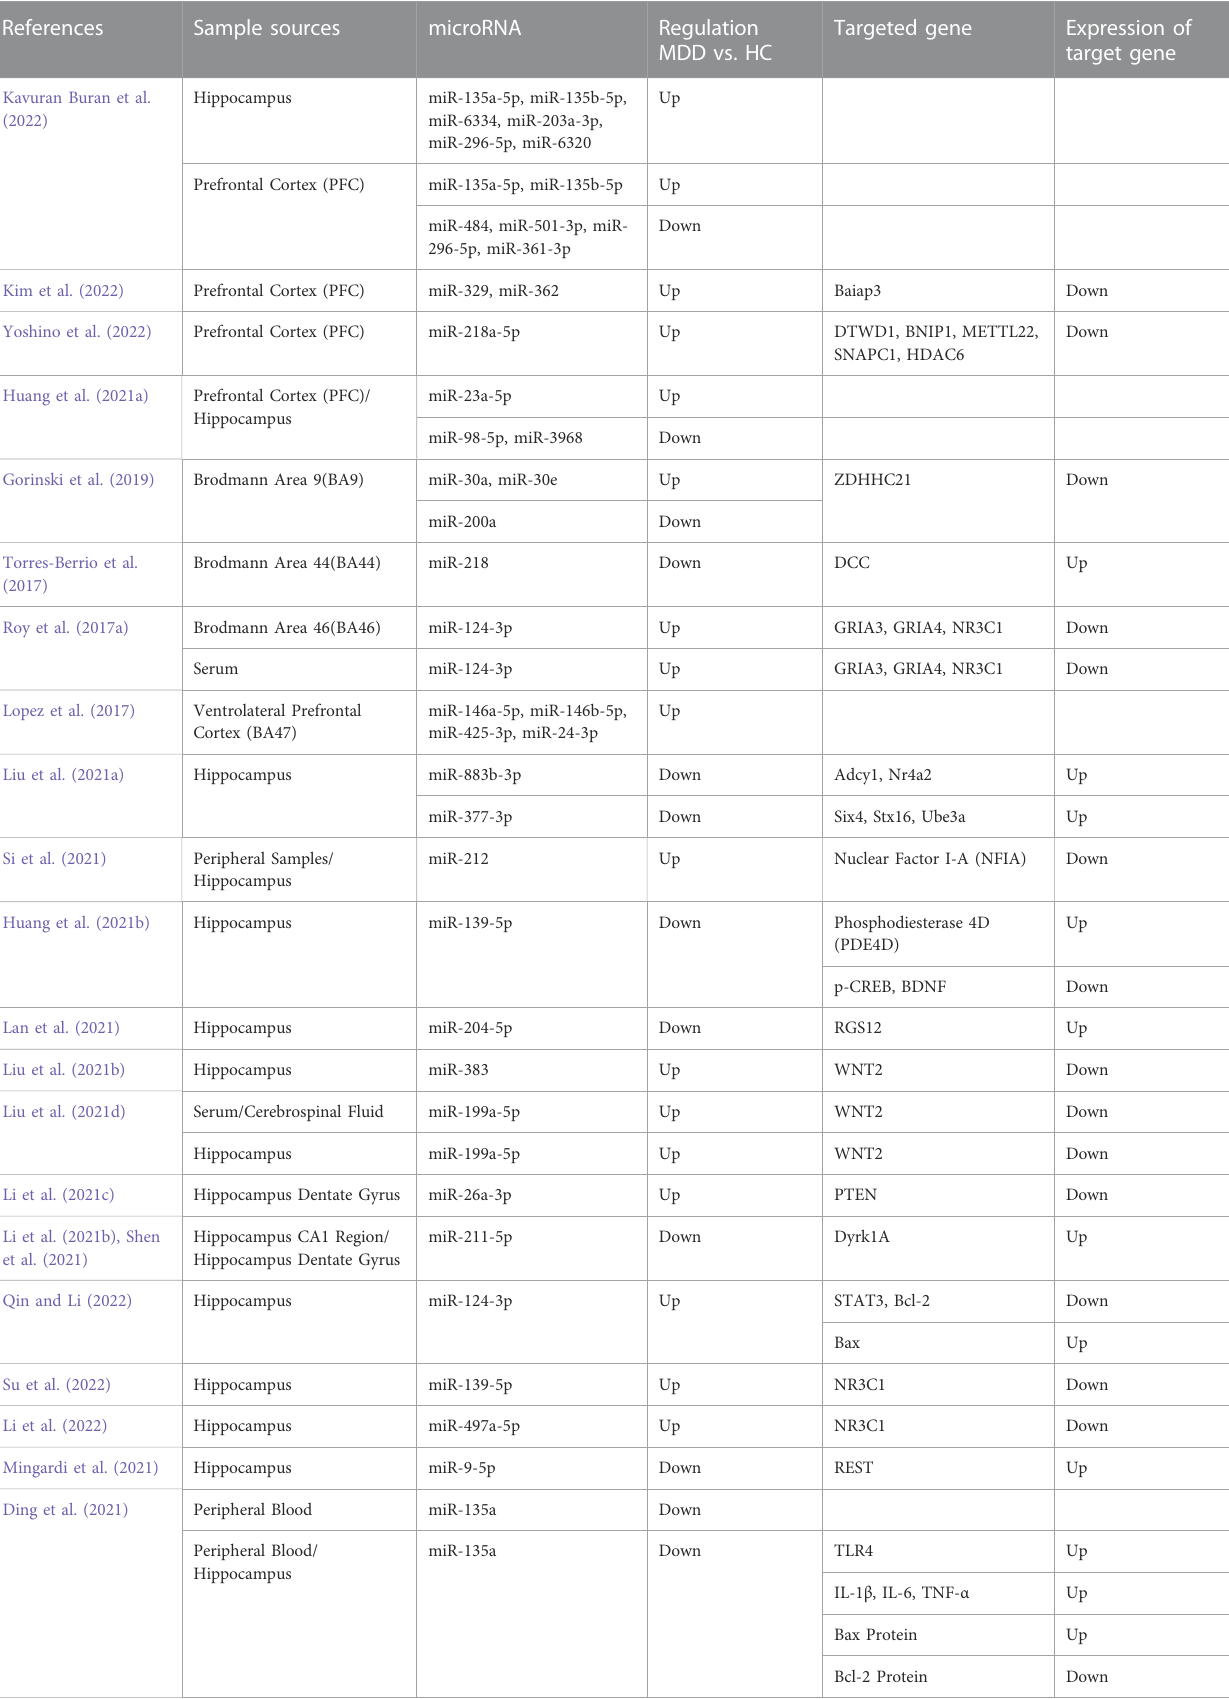
TABLE 2 Summary of researches on the changes in the levels of microRNAs and their target genes in experimental animals induced to develop